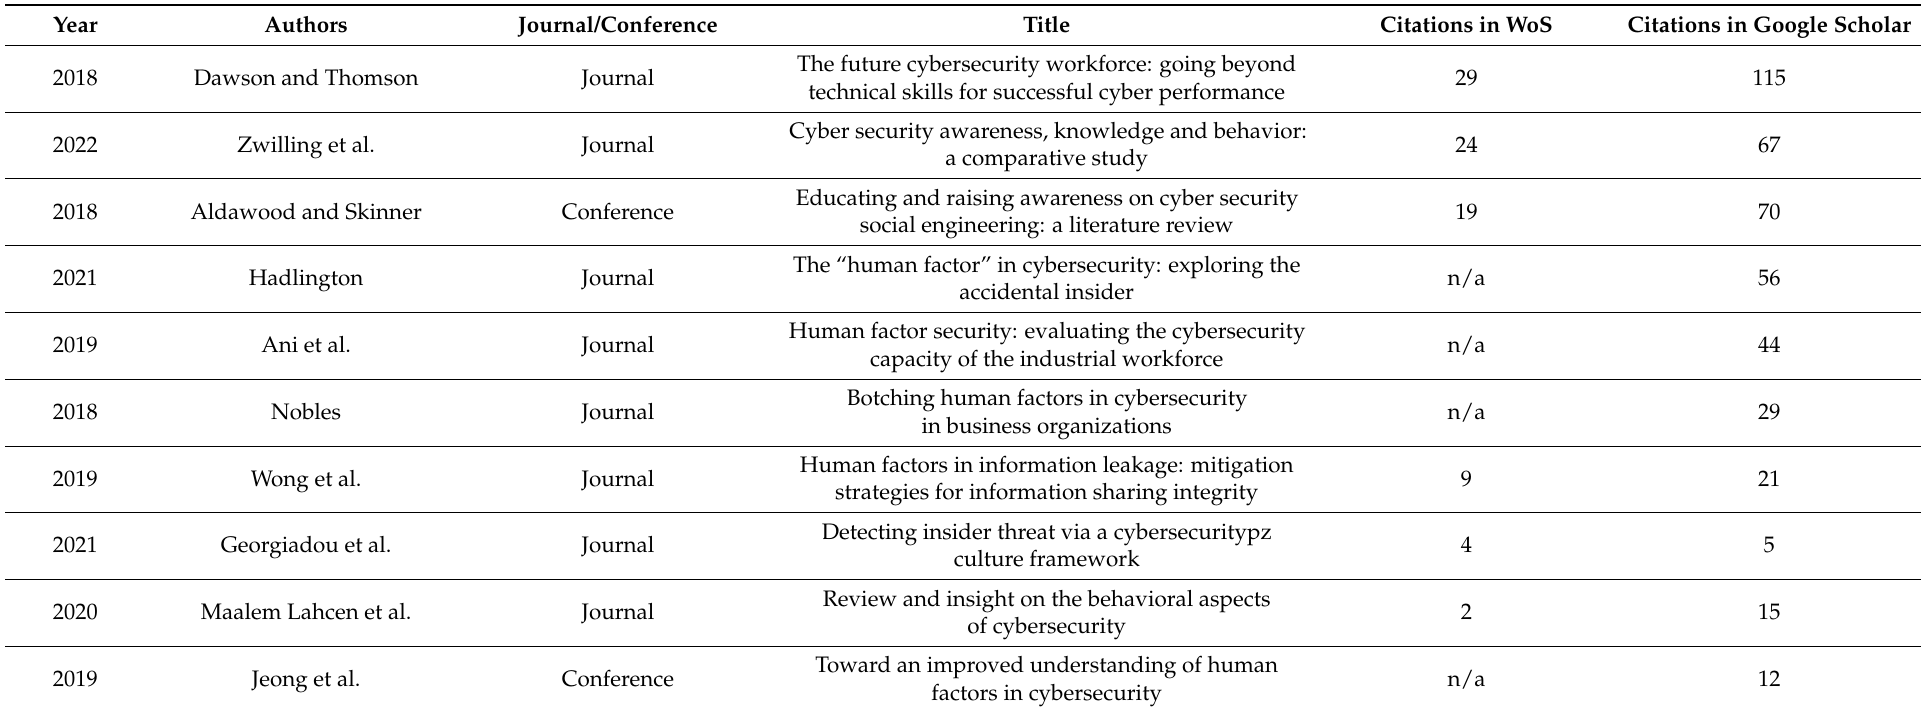
Table 2. The most cited studies in the sample, with citation